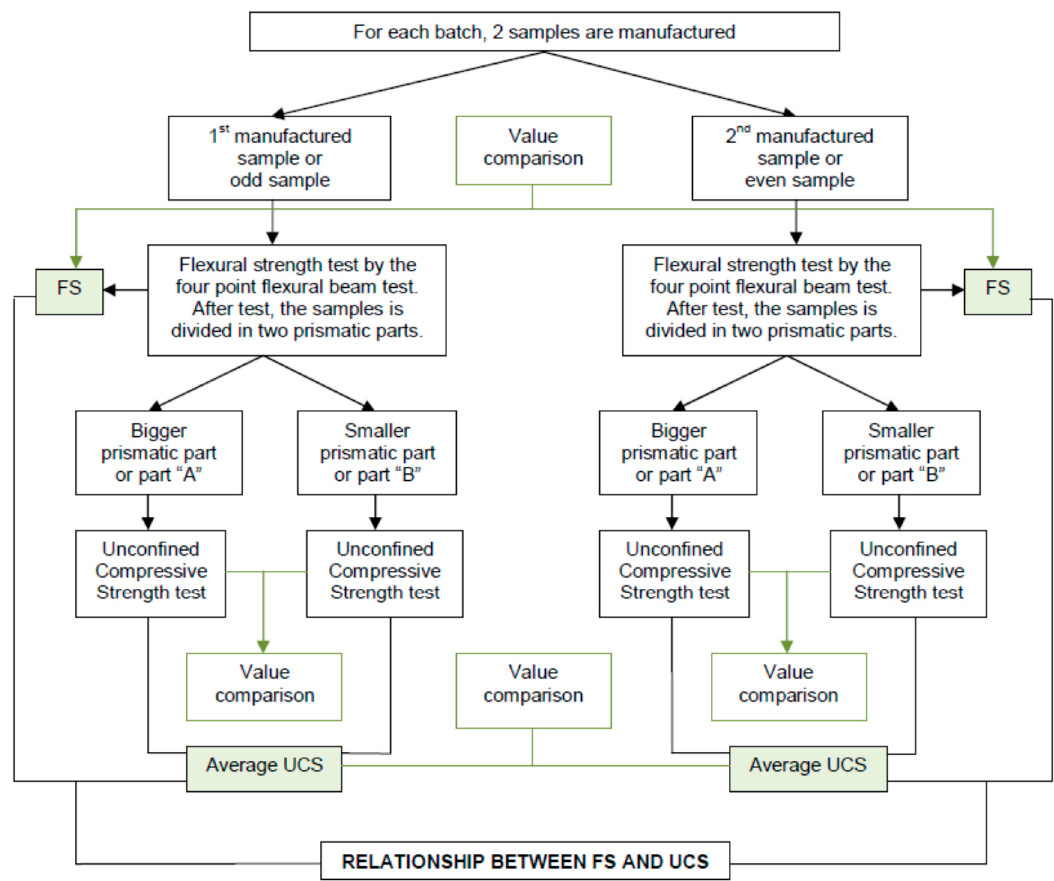
Figure 5. Conducted test program for verifying the consistency of the proposed compaction procedure.